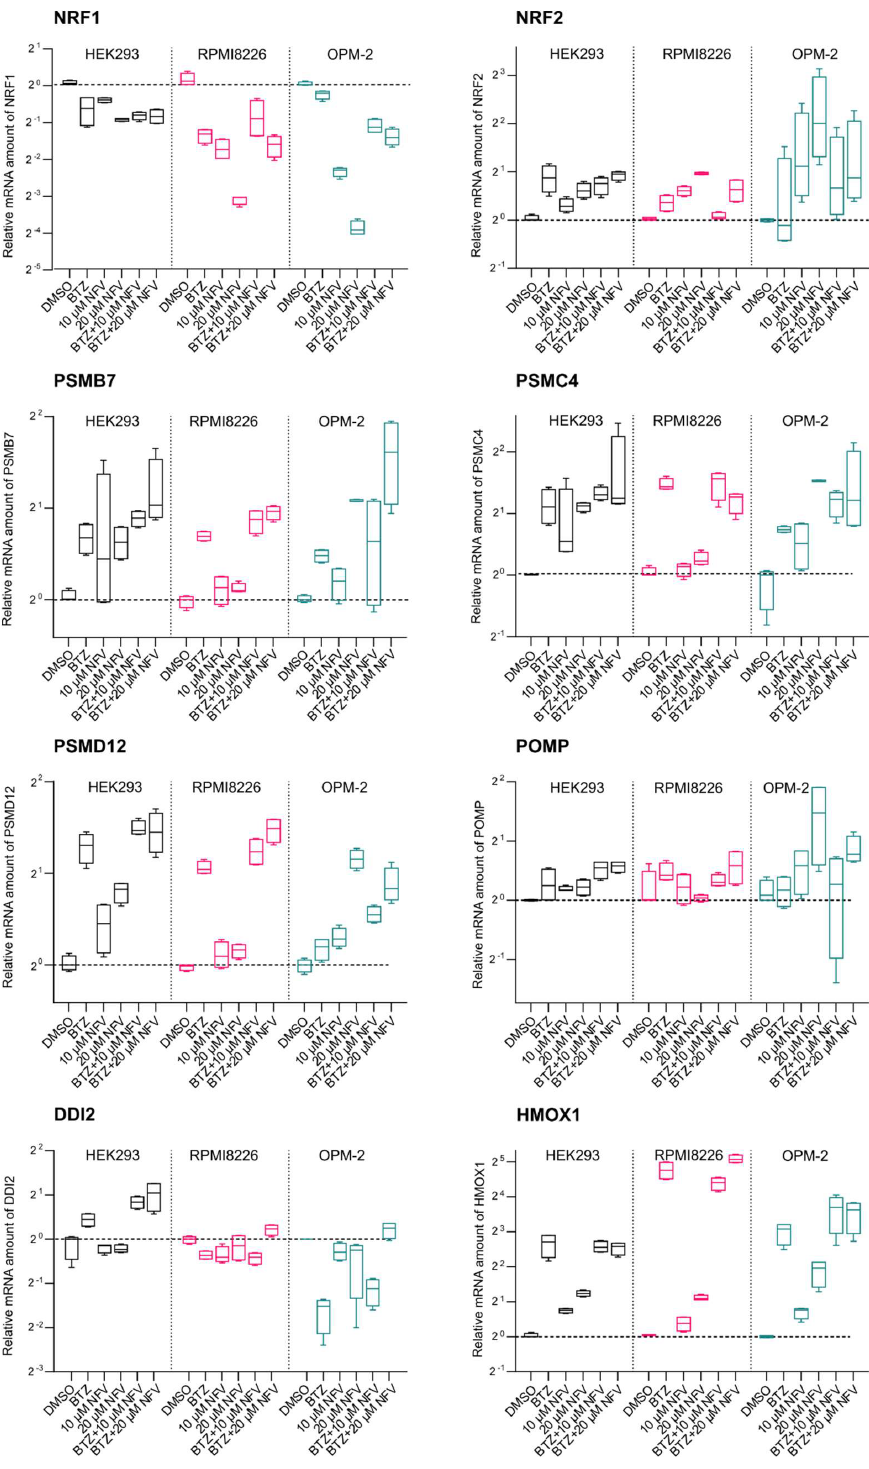
Figure 4. Nelfinavir decreases TCF11/Nrf1 gene expression and activates Nrf2. Quantitative RT-PCR analyses of the indicated genes are shown. HEK293, RPMI8226, and OPM-2 cells were treated with combination for 16 h. RNA extracted from the cells was converted to cDNA and used for RT-qPCR with the primers listed in Table S1. mRNA levels of GAPDH were used for normalization. The boxes indicate interquartile ranges, while whiskers denote minimal and maximal values ( n =